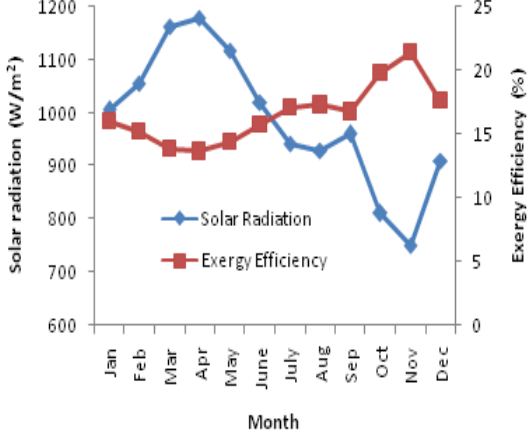
Figure 8. Monthly variations of exergy efficiency and solar radiation variation of a solar PV module The effect of temperature on solar PV module exergy efficiency is shown in Figure 9. The average exergy efficiency varied between initial and final values by approximately 36.42% with the corresponding increase in solar PV module temperature of